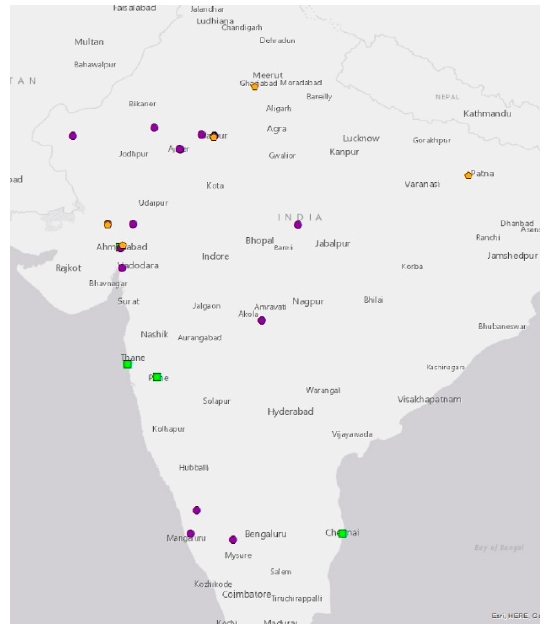
Figure 2. Places of preservation of Amitagati’s Dharmapar ī k ṣ ā . Religions 2019 , 10 , x FOR PEER REVIEW